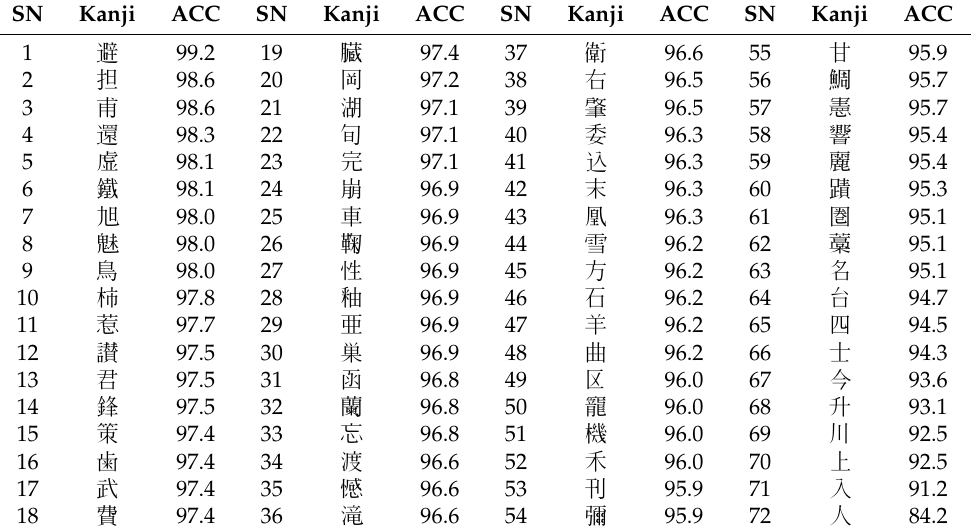
Table 4. Identification accuracy (in %) of SVM for each character.